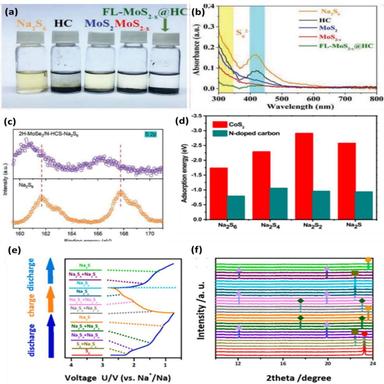
a) Photographs of polysulfide adsorption tests with and without addition FL-MoS2x@HC, and the corresponding b) UVevis spectra of taken after 2 h. Reprinted (adapted) with permission from Ref.. Copyright 2021 John Wiley & Sons. c) comparison of high-resolution XPS spectra of S 2p for pristine Na2S6 and 2HeMoSe2/N-HCS þ Na2S6. Reprinted (adapted) with permission from Ref.. Copyright 2020 Royal Society of Chemistry. d) comparison of adsorption energies of Na2Sx species on CoS2 and